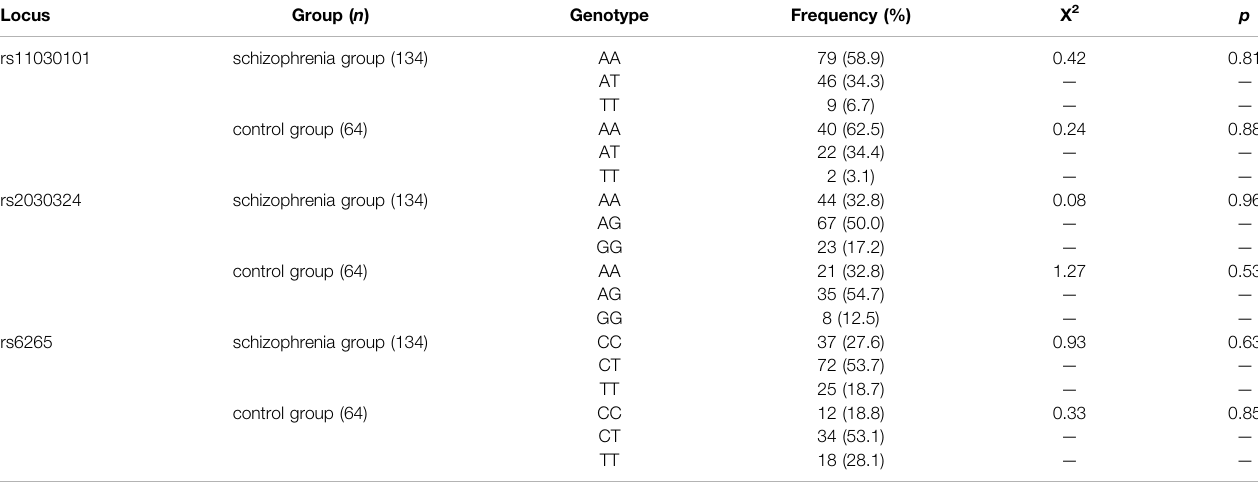
TABLE 1 | Hardy – Weinberg equilibrium test for BDNF genotypes. Locus Group ( n